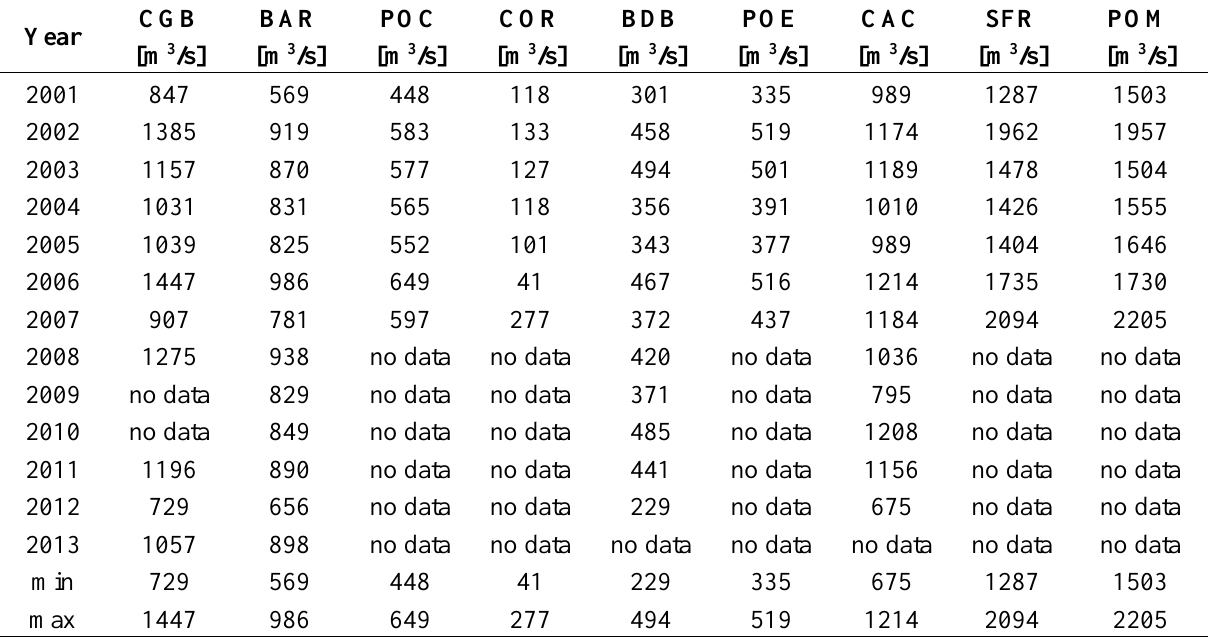
Table A3. Mean of maximum discharge (Dec-Apr) of Hidroweb stations from ANA (Agência Nacional de Águas: National Water Agency in Brazil) (Figure 1a, stations labelled in